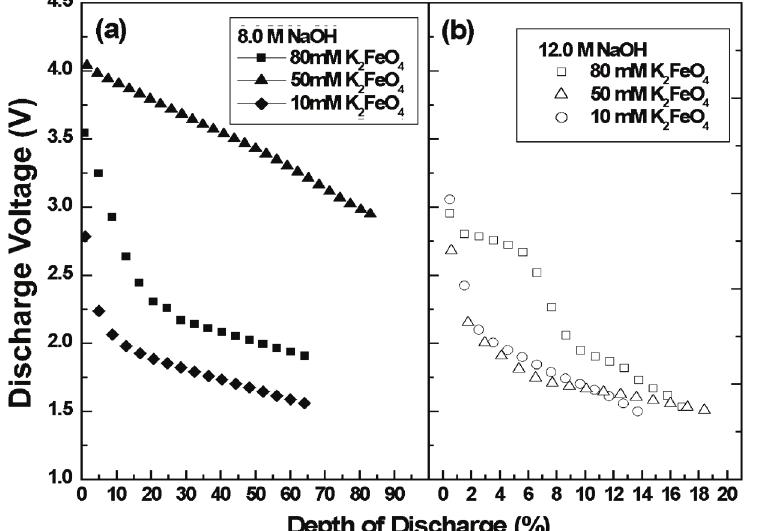
Figure 4. The discharge behavior of a 191 nm Fe(VI) film on a Pt electrode with various deposition conditions at 20th cycle. Films are deposited at a constant current of 10 mA for FeO ] in 8.0 M (a) or 12.0 M NaOH (b). 10 s from electrolytes containing various [K 2 4 Subsequent nonaqueous galvanostatic cycling consists of charge at 0.02 mA cm – 2 to 100% of the intrinsic 3e – Fe capacity, as limited by a maximum cut0ff voltage of 4.2 V, followed by discharge at 0.01 mA cm – 2 to 90% DOD of this capacity as limited by a 1.5 V minimum voltage